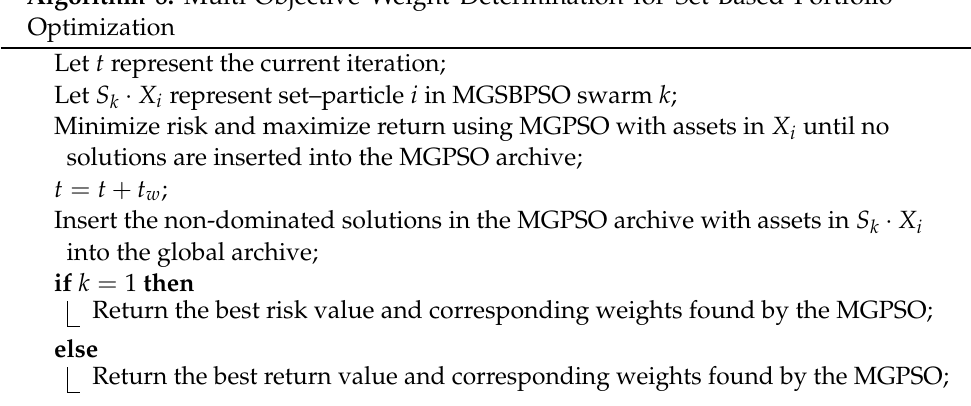
Algorithm 8: Multi-Objective Weight Determination for Set-Based Portfolio